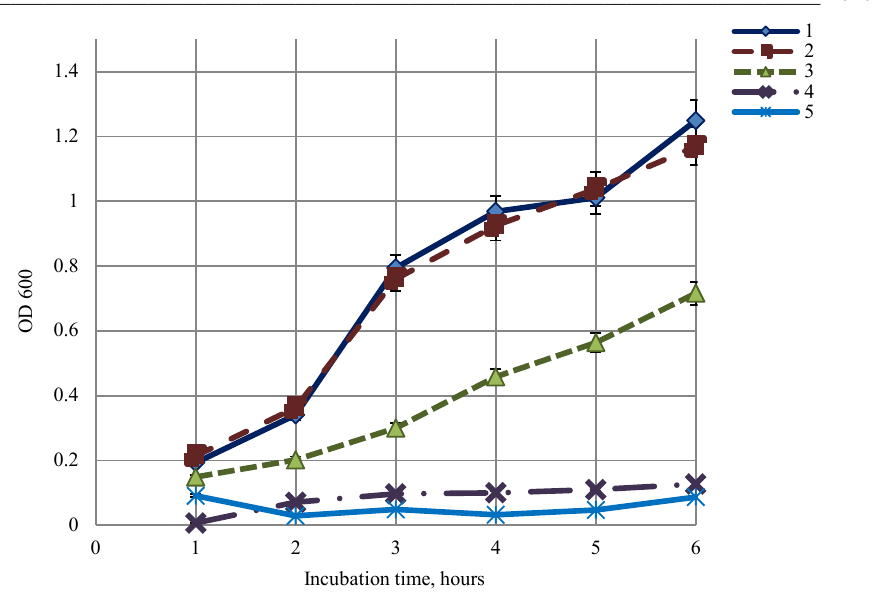
Fig. 3. Antimicrobial action of peptide fraction obtained from L. plantarum 8Р - А3 culture, on E. coli ATCC 10798 growth. Curve 1 – enterobacteria growth on LB medium (positive control); 2 – fraction, treated by trypsin; 3 – fraction at amount 0.1 % vol.; 4 – fraction at amount of 0.2 % vol.; 5 – ampicillin 10 mg/L.